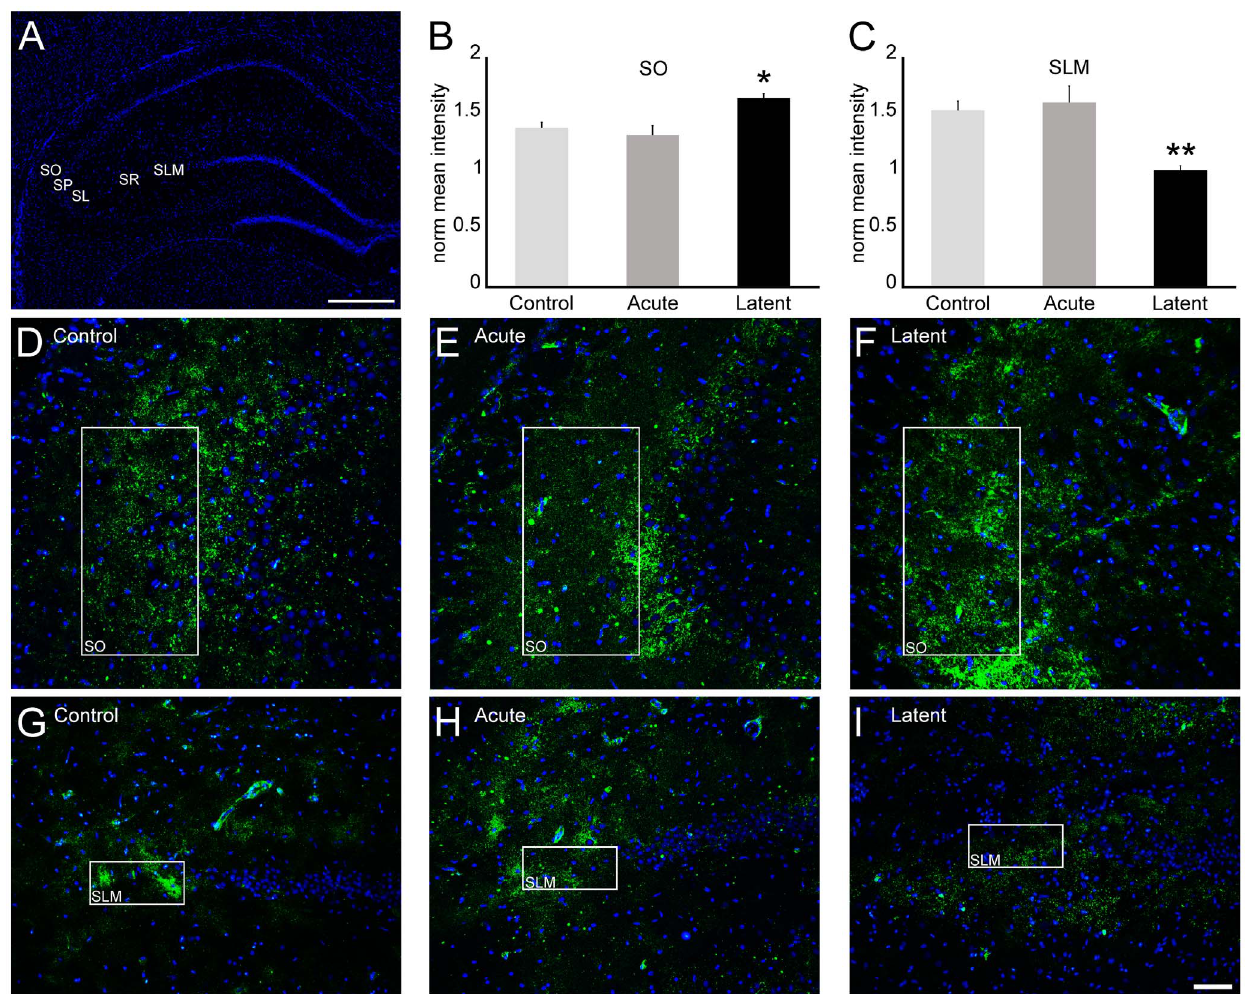
Figure 6. Cx45 distribution in CA3 after epileptiform activity. To examine Cx45 (green) distribution into CA3, we conducted immunofluorescence experiments in coronal sections of rats from control, acute and latent groups counterstained with DAPI (blue). (A) Coronal section labeled with DAPI showing CA3 strata oriens (SO), pyramidale (SP), lucidum (SL), radiatum (SR) and lacunosum-moleculare (SLM). (B, C) Quantification of mean pixel intensity (n=4 animals per group) showed significant increase in (F) SO and decrease in (I) SLM in the latent period, compared with control animals (D, G). In these subfields, we were not able to detect differences in the acute period (E, H), as well as in the other strata in both acute and latent periods (data not shown). Bars represent standard errors of the mean. * P , 0.05, ** P , 0.01 vs . Control group in Tukey’s HSD pairwise comparisons after one-way ANOVA. Scale bar: 50 m m.